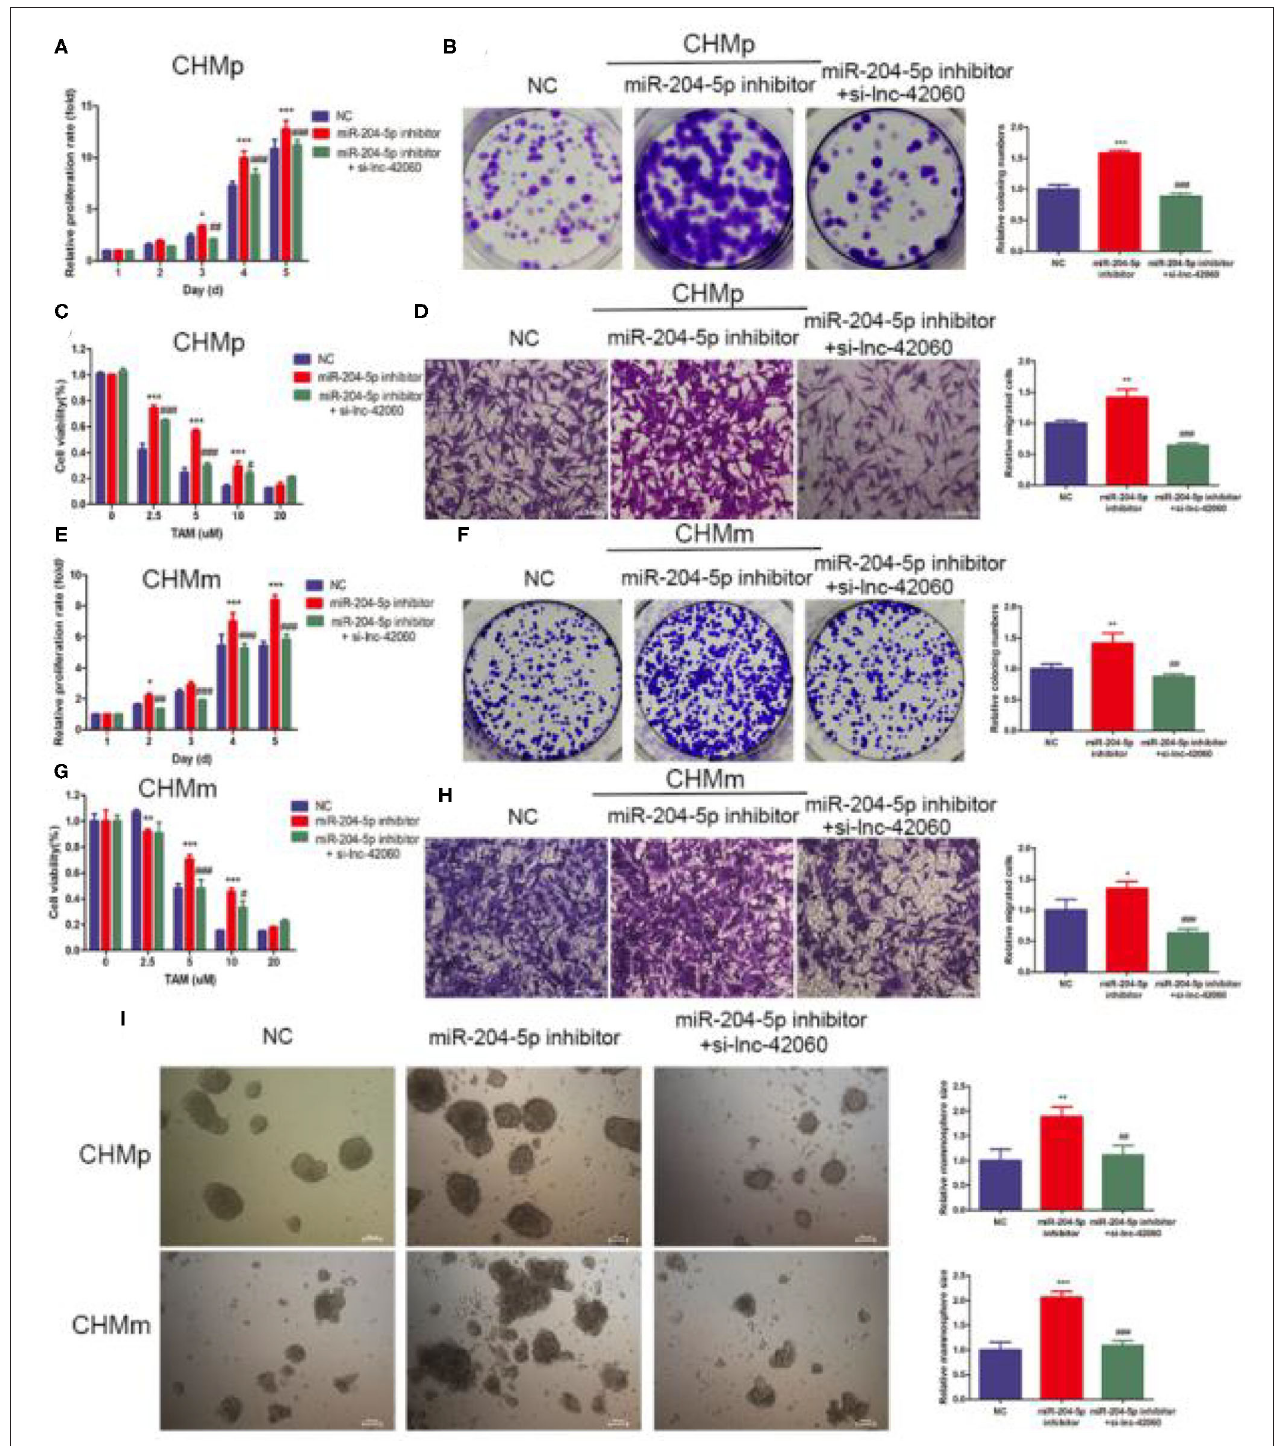
FIGURE 5 | lnc-42060 sponges miR-204-5p to regulate cell proliferation, migration and increased TAMR in CMGTs. (A,E) CCK8 assay was conducted to evaluate cell proliferative ability in CMGTs. (B,F) Colony formation is shown in CMGTs. (C,G) CCK8 assay shows the variation in TAM sensitivity in CMGTs. (D,H) Transwell migration was conducted to evaluate cell migration ability (magnification, 200 × ) in CMGTs. (I) Microemulsion size in CMGTs (magnification, 200 × ). Data are presented as means ± SD of at least three independent experiments. Compared with control groups, * P < 0.05, ** P < 0.01, *** P < 0.001; compared with miR-204 groups, # P < 0.05, ## P < 0.01, ### P <